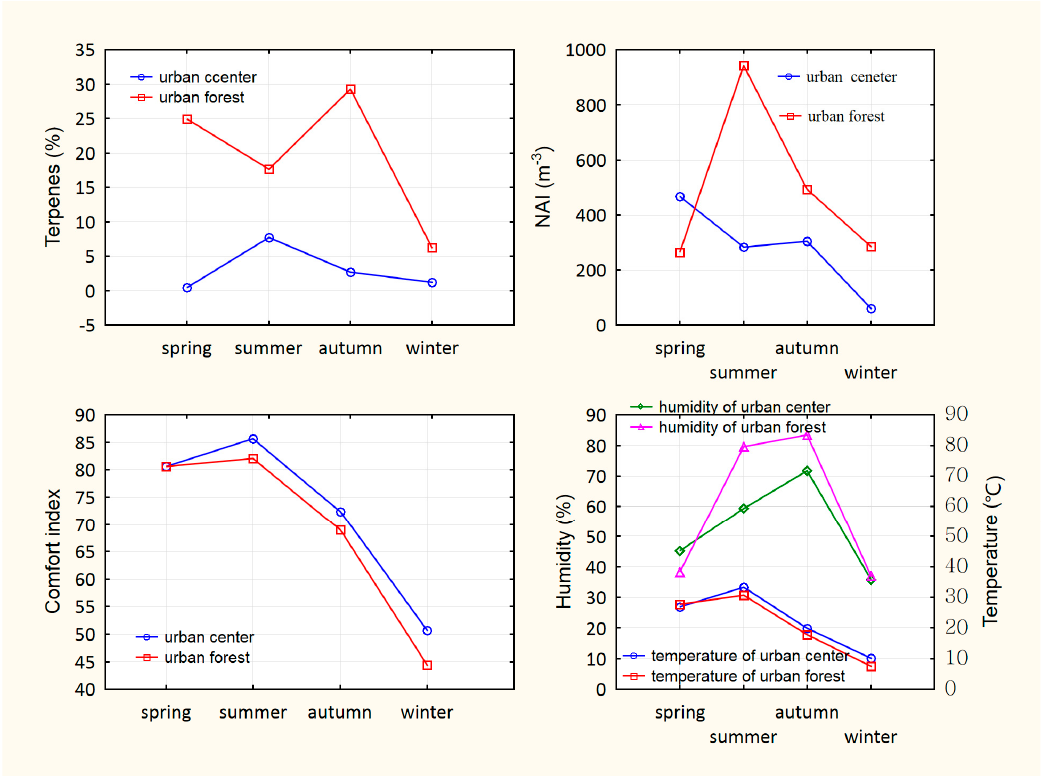
Figure 2. The air quality and atmospheric environment among four seasons, including NAI, temperature, humidity, the comfort index, and terpenes.